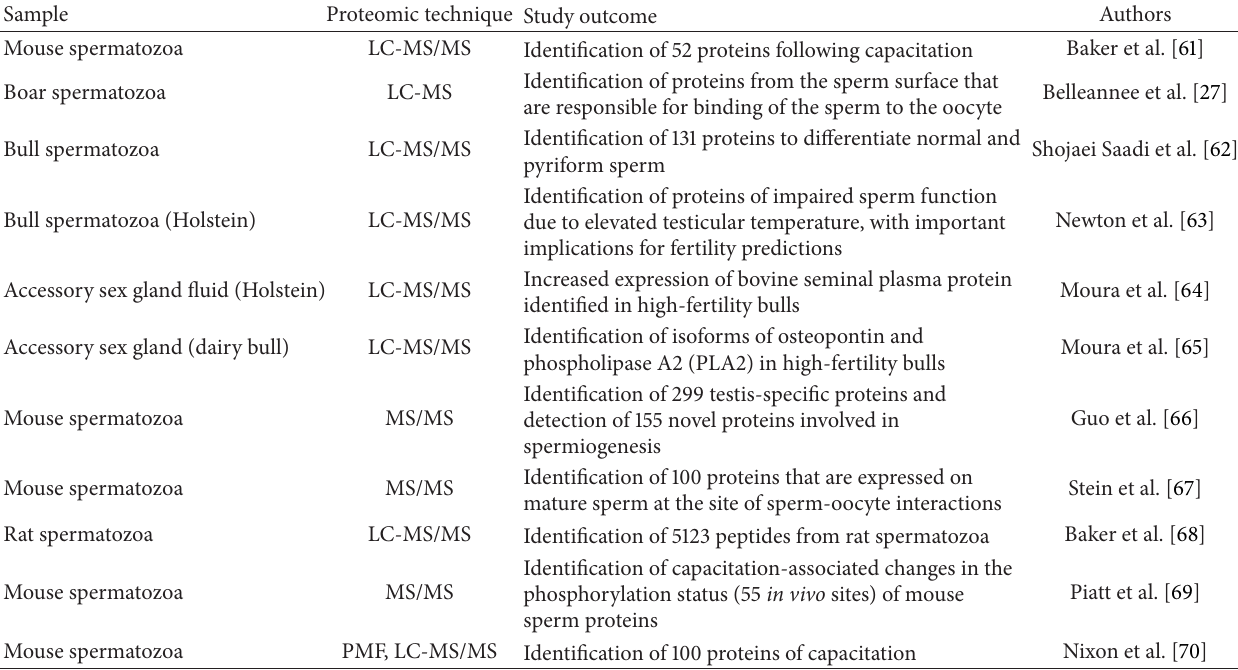
Table 1: Summary of major proteomic studies to define the fertile male (animal models).